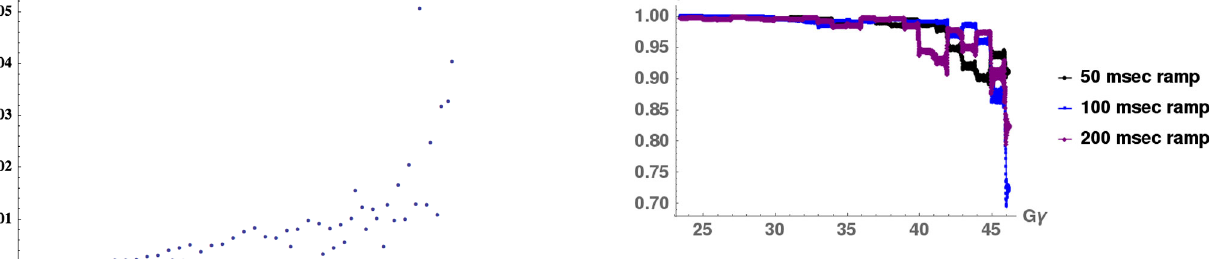
FIG. 4. Z GOUBI tracking results for 8 particles at 1000 mm- mrad normalized emittance. Comparing ramp times 50 to 200 msecs. The vertical axis h S represents the average vertical y i . components of the spin K j